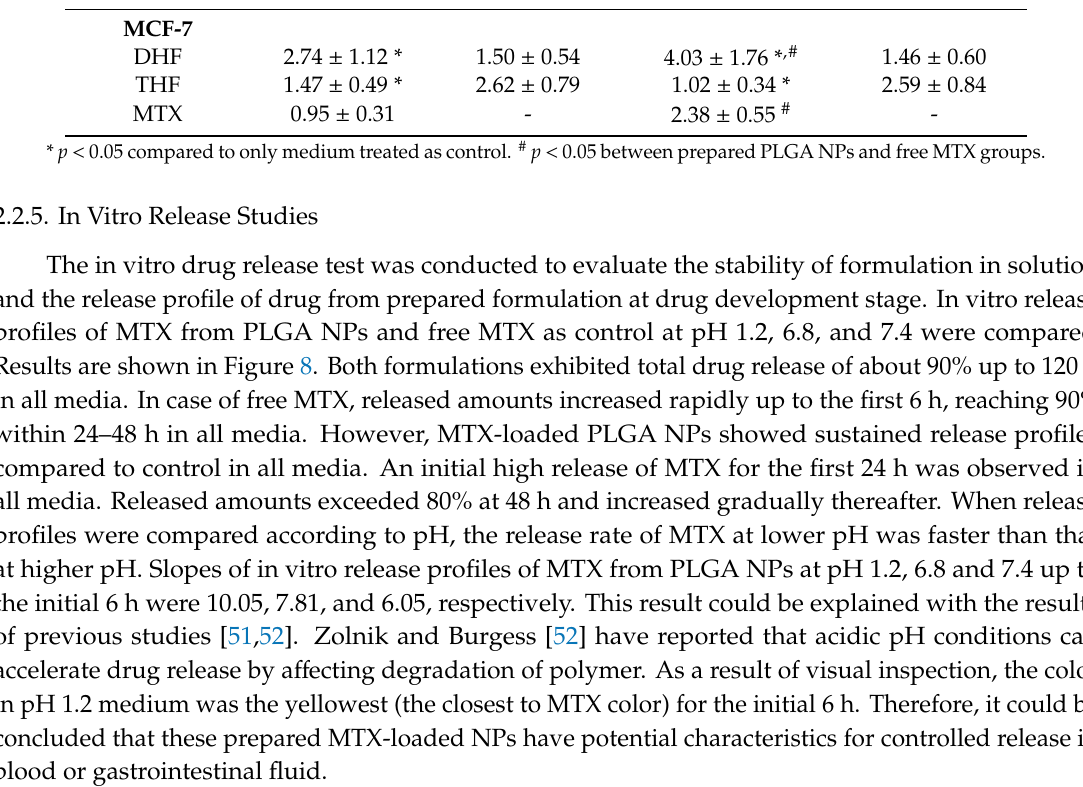
Table 5. Concentrations of dihydrofolate (DHF), tetrahydrofolate (THF), and MTX in CWR22Rv1 and MCF-7 cells after incubating cells with free MTX, blank NPs, or MTX-loaded NPs for 144 h ( n = 3, mean ± SD).